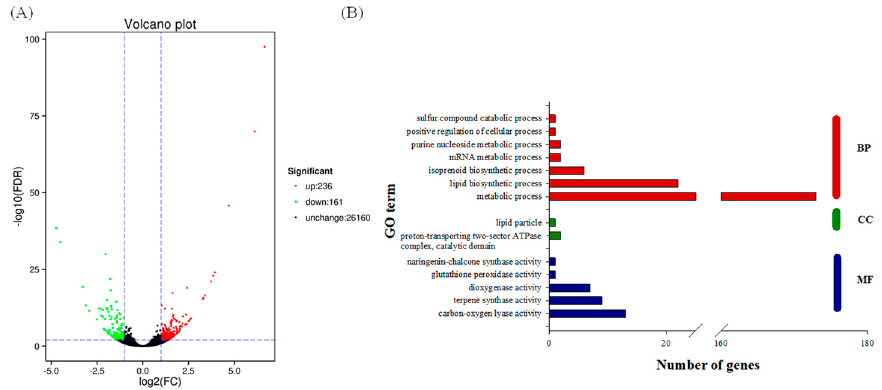
Figure 2. Volcano plot ( A ) and gene ontology (GO, B ) analysis of differentially expressed genes (DEGs) between ammonium (A-N)- and nitrate (N-N)- treated stevia leaves. In ( A ), the red dots represent the upregulated DEGs, while the green dots represent the downregulated DEGs, with a minimum fold-change threshold of 2 and a significant level of 0.05. In ( B ), the y -axis represents different GO terms that belong to BP (biological processes), CC (cell component) or MF (molecular functions) subcategories, while the value on the x -axis shows the number of genes in the corresponding GO term.